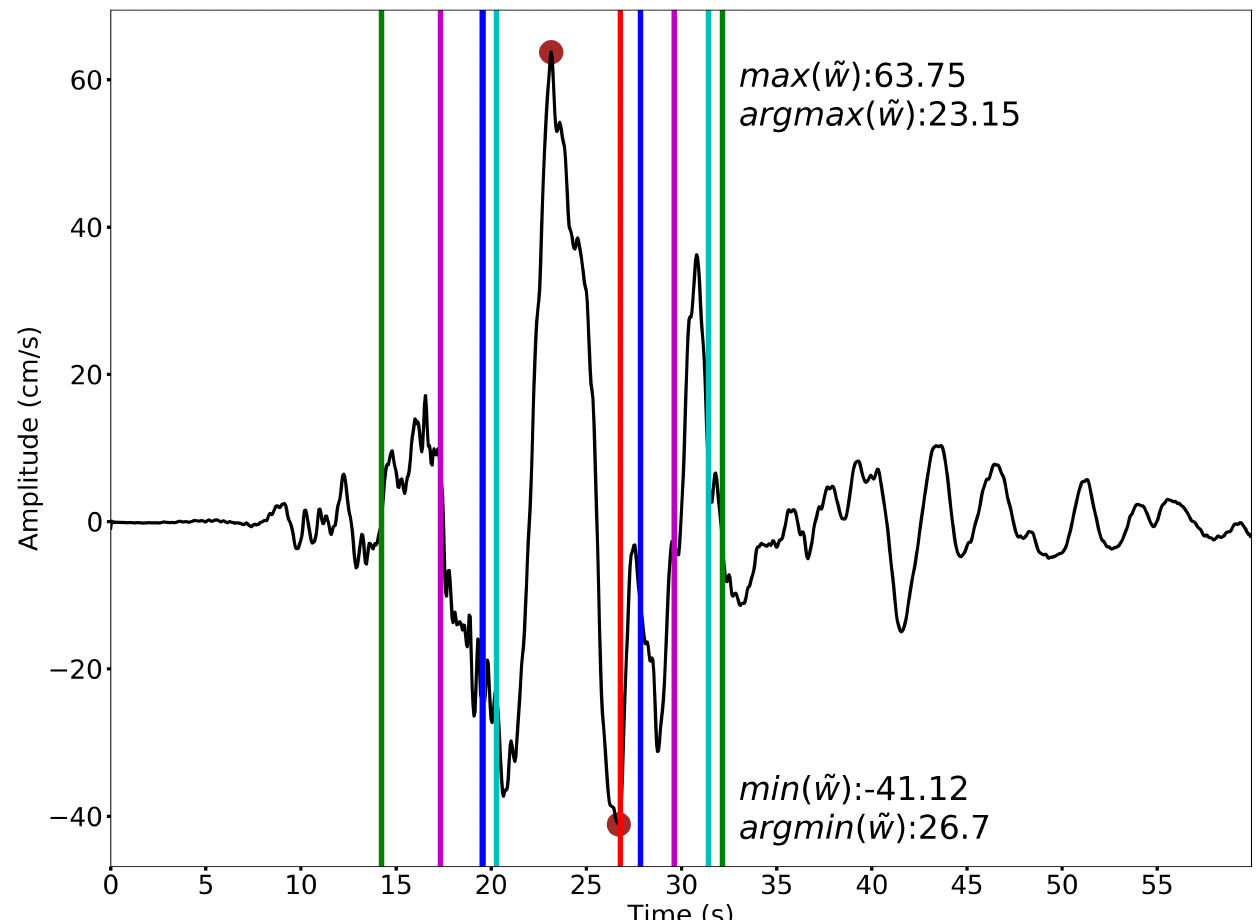
Figure 3. Representation of the waveform ( (cid:126) w ) and the input data ( (cid:126) v ) on the 23rd of November 1980 Irpinia, Italy earthquake ( M w = 6.9) ground motion record at Arienzo station ( R jb = 52.93km). Initiation and termination positions of manual picking, CNN model, Chang et al. [22], Ertuncay and Costa [23], and Shahi and Baker [17] are given with cyan, magenta, green, red, and blue colours,